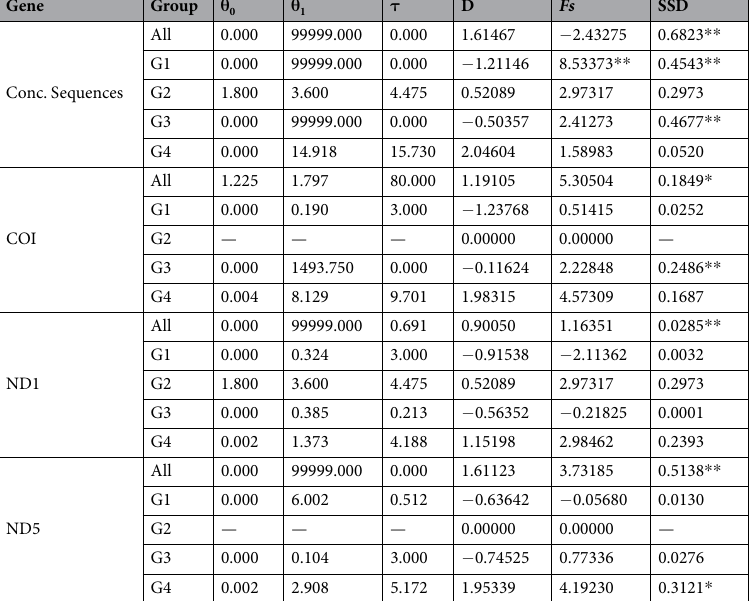
Table 6. Parameters of demographic history of the collated 23 populations and each of four population’s groups independently based on concatenated mtDNA sequences. θ 0 , Effective population size before expansion; θ 1 , effective population size after expansion; τ , population expansion time; D, Tajiama’s D; Fs , Fu’s; SSD, sum of squared deviations between observed and expected mismatch under a sudden expansion model; * indicated p < 0.05, ** indicated p <